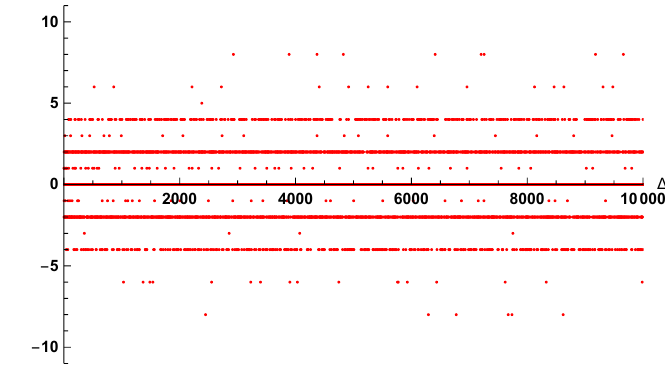
Figure 1 . a (cid:1) , the q expansion coe(cid:14)cient of the torus one point function of (cid:15) as a function of